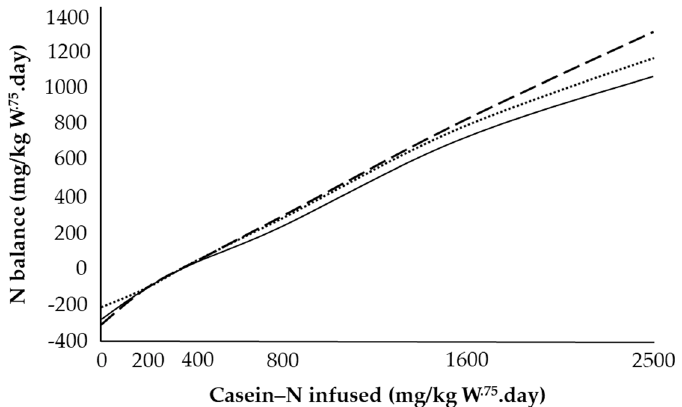
Figure 7. N balance response in relation to volatile fatty acid level and composition, at increasing casein-N infusion. Maintenance (450 kJ/kg W .75 .day) on a low propionic acid mixture (solid line); maintenance on a high-propionic acid mixture (dashed line); 1.5 X maintenance on a low propionic acid mixture (dotted line). Adapted with permission from [61].